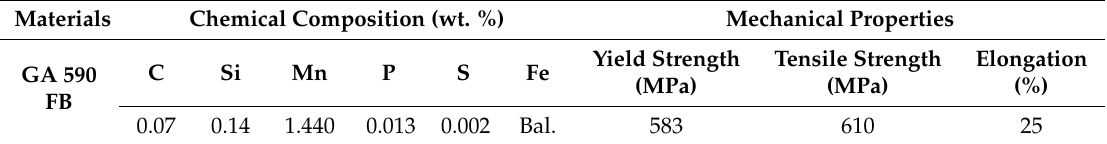
Table 1. Chemical composition and mechanical properties of the base material.